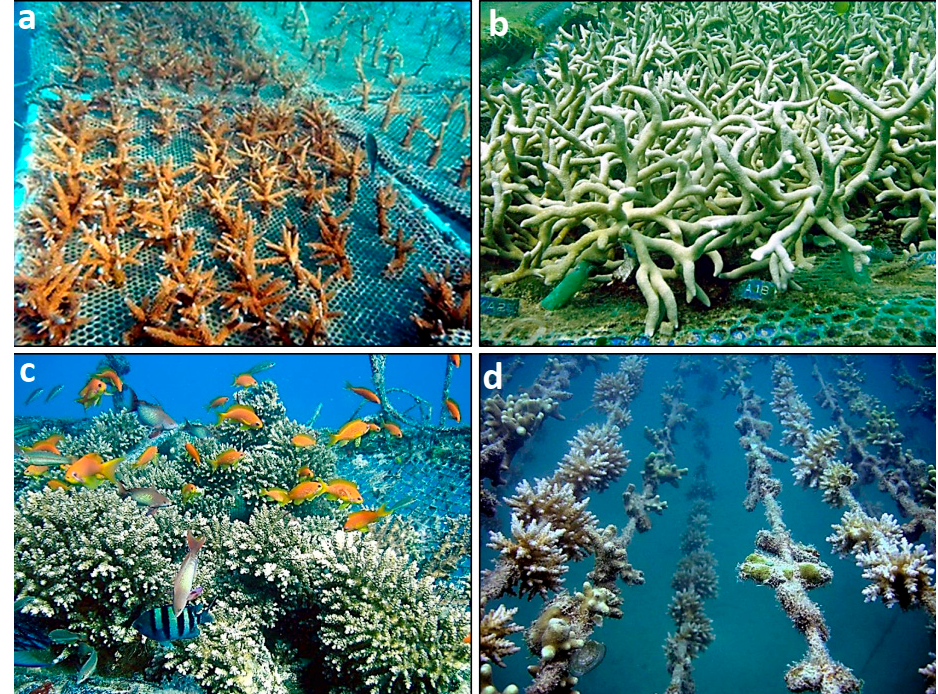
Figure 1. Three types of midwater floating nurseries, the first step of the “gardening” tenet. Nurseries are adapted for various transplantation needs and practices. ( a , b ), the regular ‘bed’ nursery, where corals (usually mono-species cultures) are directly farmed on the nursery base. ( a ) a short period after inception, where most of the mesh-base of the nursery is still seen ( Acropora formosa , Bolinao, the Philippines). ( b ) a ‘bed’ nursery completely covered with Montipora digitata colonies (Bolinao, the Philippines). ( c ) a classical floating nursery. The nursery substrate is made of a rope net (sized 10 × 10 m). Coral